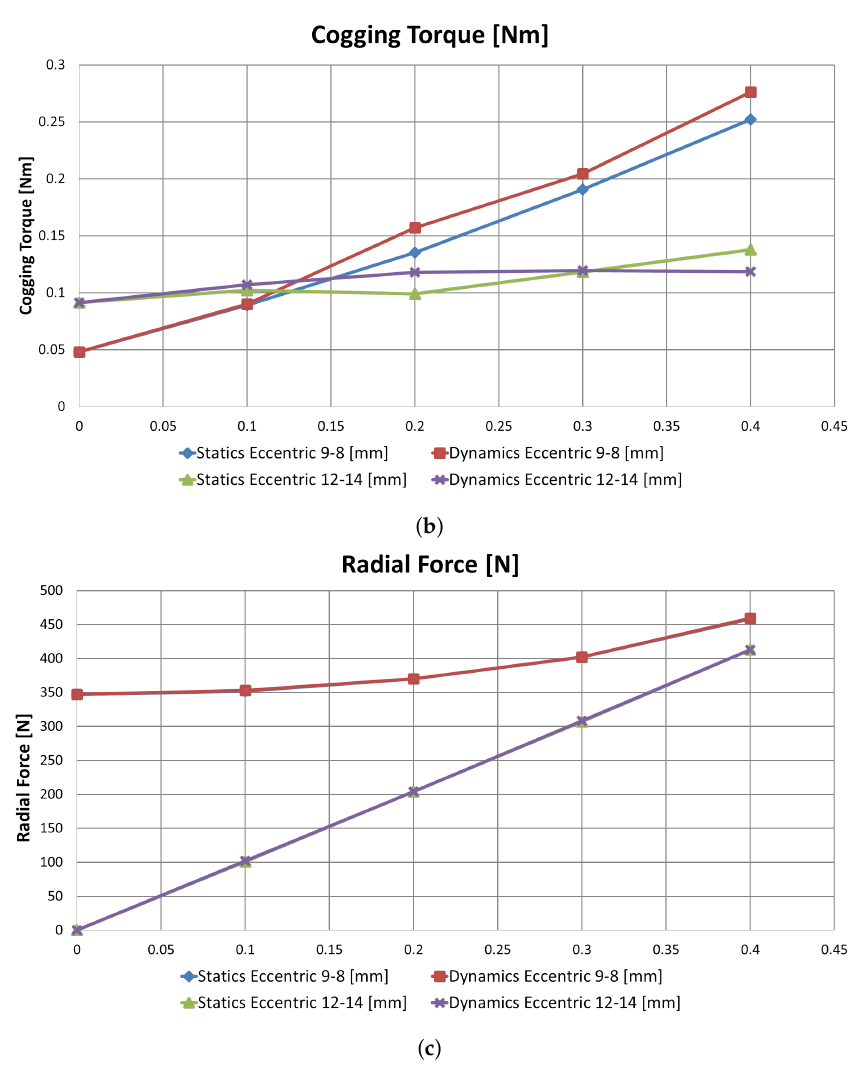
Figure 11. Correlation between severity of mechanical defects and machine performances of slot–pole combinations 9-8DL and 12-14DL: ( a ) trend of torque ripple; ( b ) trend of cogging torque; and ( c ) trend of radial force for increasing values of mechanical defects.